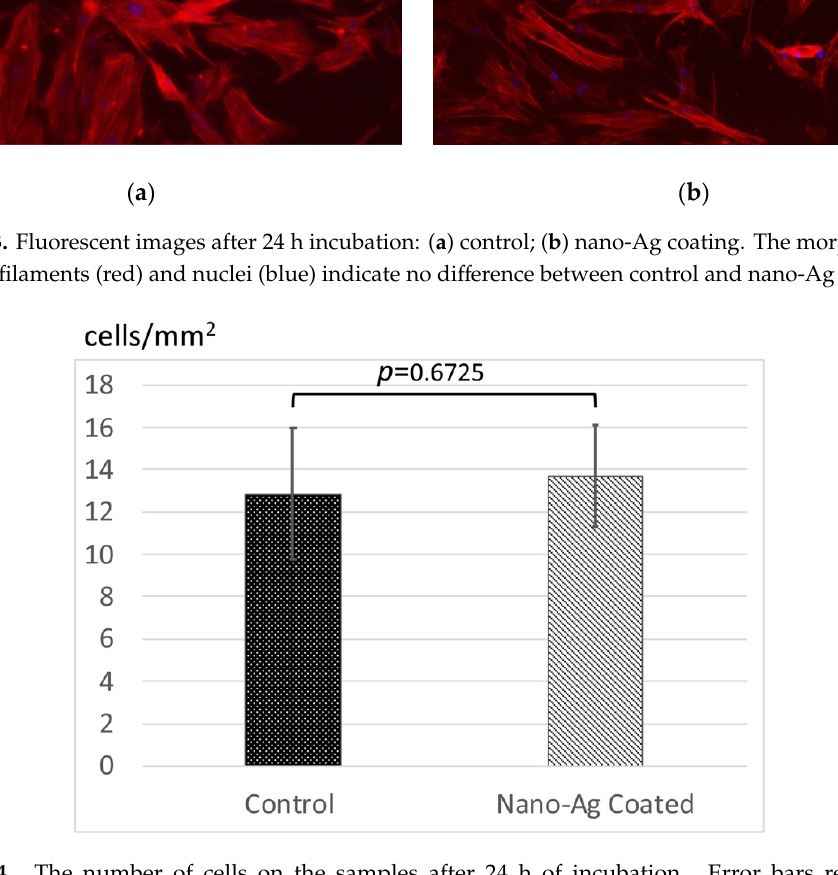
Figure 4. The number of cells on the samples after 24 hours of incubation. Error bars represent mean ± standard deviation for n = 5. The one-way analysis of variance and t -test comparisons were used for parametric analyses. There was no statistically significant difference between control and nano-Ag coating.